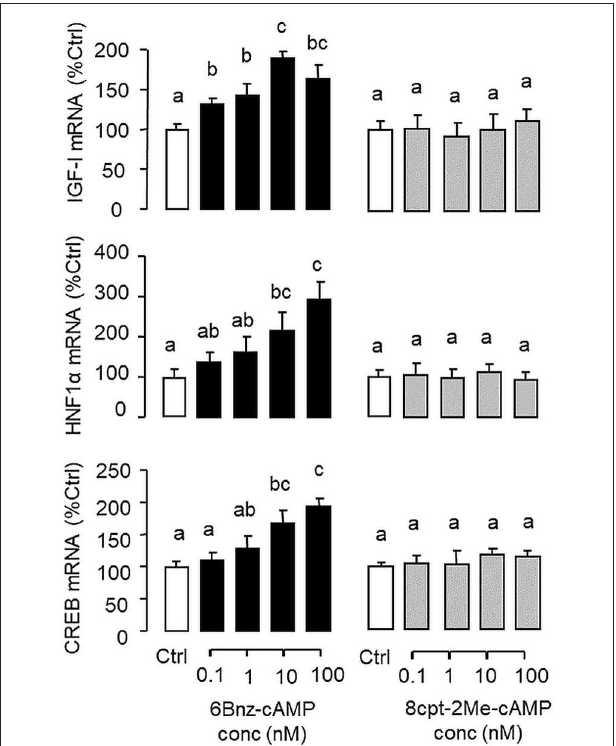
FIGURE 7 | Functional role of PKA and Epac activation on IGF-I, HNF1 α , and CREB transcript expression at the hepatic level. Carp hepatocytes were treated for 12h with increasing concentrations (0.1–100nM) of the PKA-specific cAMP analog 6Bnz-cAMP or Epac-specific cAMP analog 8cpt-2Me-cAMP. After drug treatment, total RNA was isolated from individual wells and subjected to real-time PCR with primers for IGF-I, HNF1 α , and CREB, respectively.